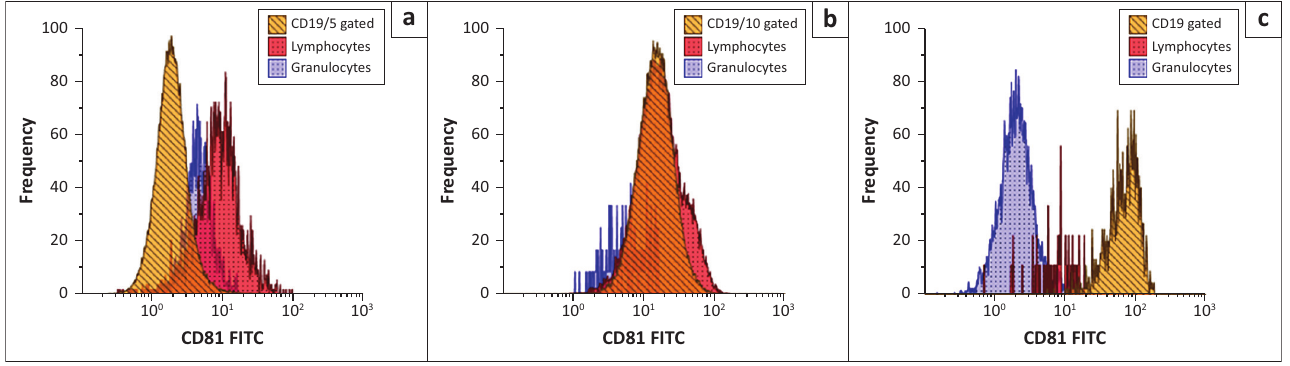
FIGURE 1: Relative expression of CD81 relative to normal T-cells and granulocytes in the CLB tube validated at the Charlotte Maxeke Johannesburg Academic Hospital flow cytometry laboratory in Johannesburg, South Africa, April 2020 to August 2020. Each plot (a, b and c) shows CD81 expression ( x -axis) versus frequency ( y -axis). In A, there is relative (weak) under-expression of CD81 in a patient with CLL gated on CD19+|CD5+; in B, there is relative over-expression of CD81 in a patient with follicular lymphoma gated on CD19+|CD10+ C is a control experiment of a paediatric sample with 20 % haematogones showing bright expression of CD81 on normal precursor B-cells gated on weak CD45+| CD19+. Orange represents the B-cells identified with CD19; the blue population represents background granulocytes identified with CD45 and side scatter, and red represents background T-cells gated on CD5 (all markers are included in the CLB panel).